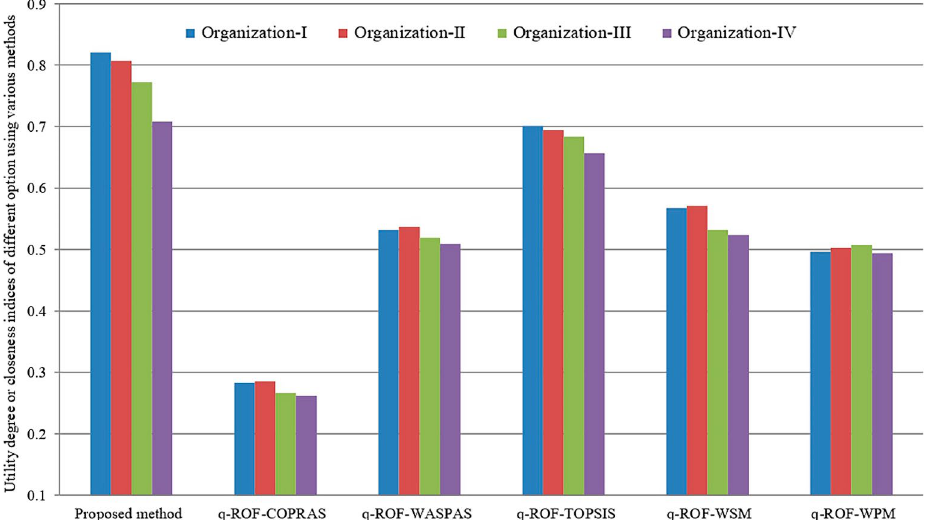
Figure 2. Utility degree of each organization to evaluate the IoT risks for SCM with extant